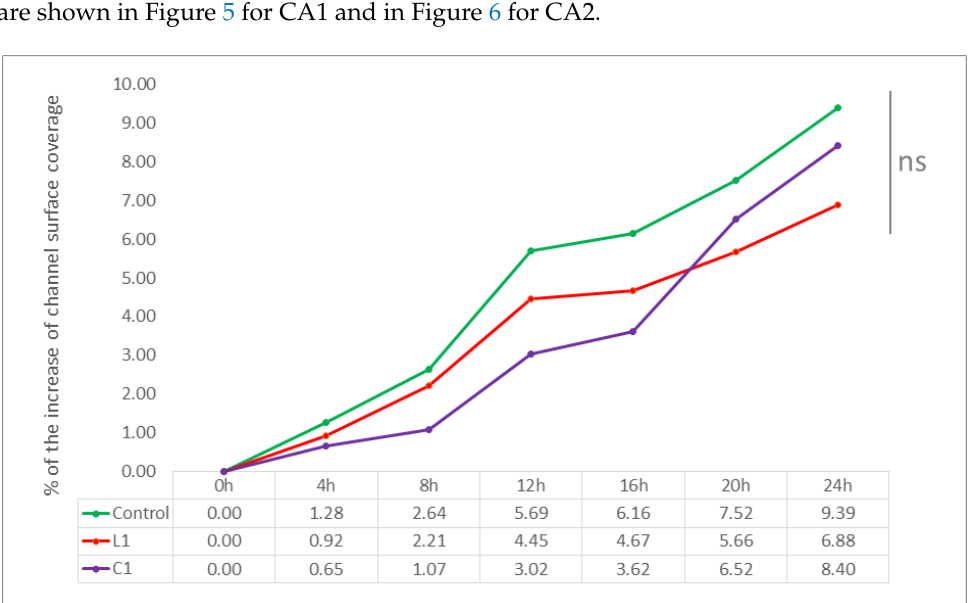
Figure 5. Growth dynamics of biofilm biomass of C. albicans strain CA1 over 24 h in the presence of lipopeptides L1 and C1, expressed as a percentage of channel coverage in the BioFlux Z1000 system. For all tested samples, the biofilm obtained after 24 h of growth in the absence of any substances (a biofilm development phase) was taken as the starting point. All experiments were repeated in triplicate. NS—non-significant.